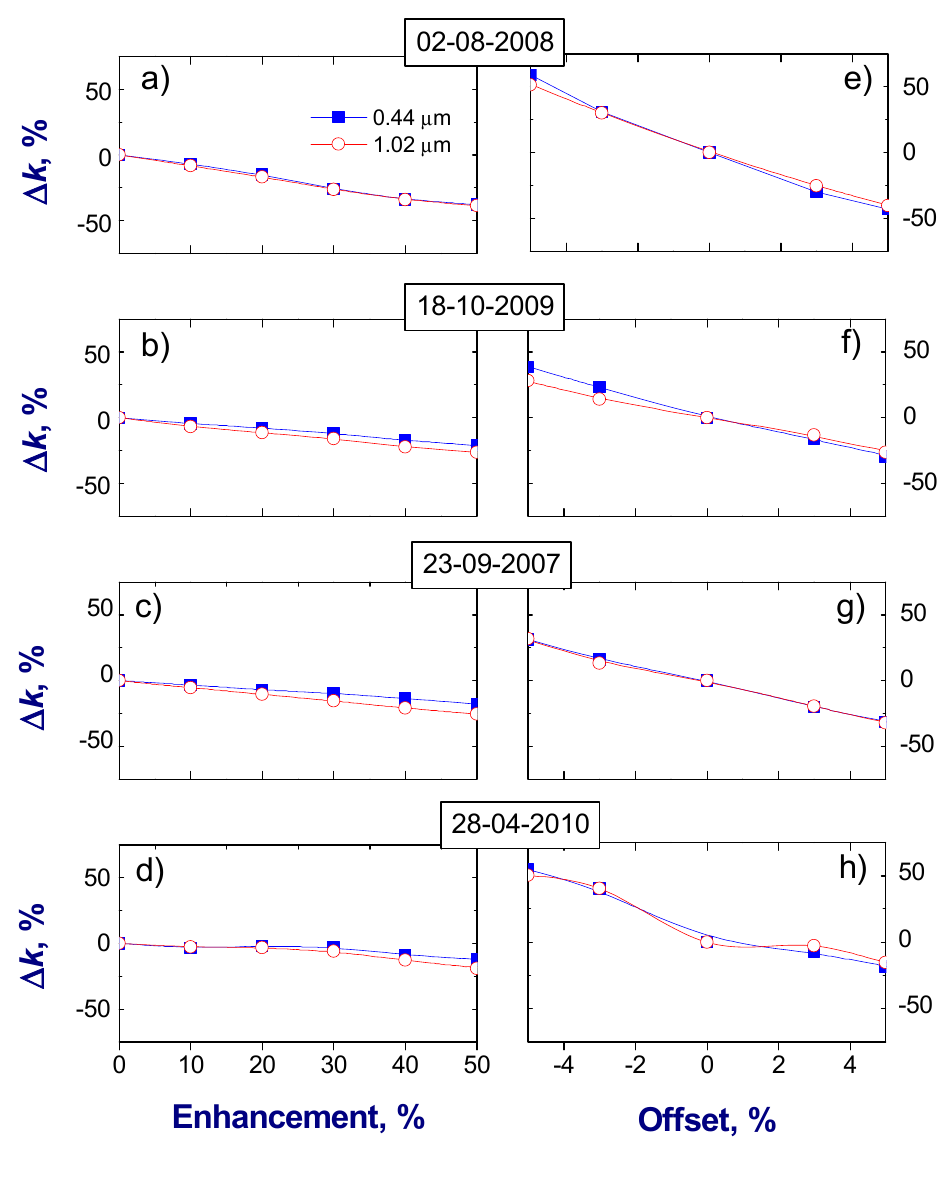
Figure 5. Relative difference between “true” and retrieved values of the imaginary part k of the refractive index for four selected days and two wavelengths: 0.44 μ m (blue) and 1.02 μ m (red). Left column: differences of k as a function of the assumed enhancement at 1.02 μ m wavelength. Right column: differences of k as a function of the assumed